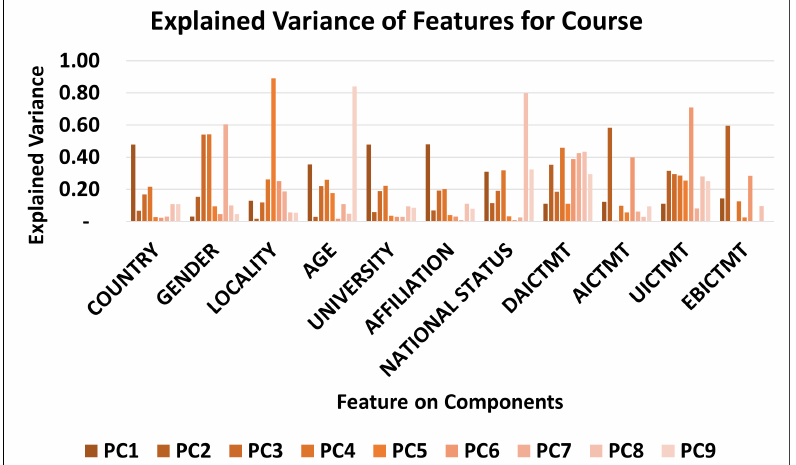
Figure 4. ( a ) Features importance to identify Gender by GB and ( b ) PCA components and Explained variance for Age-group.